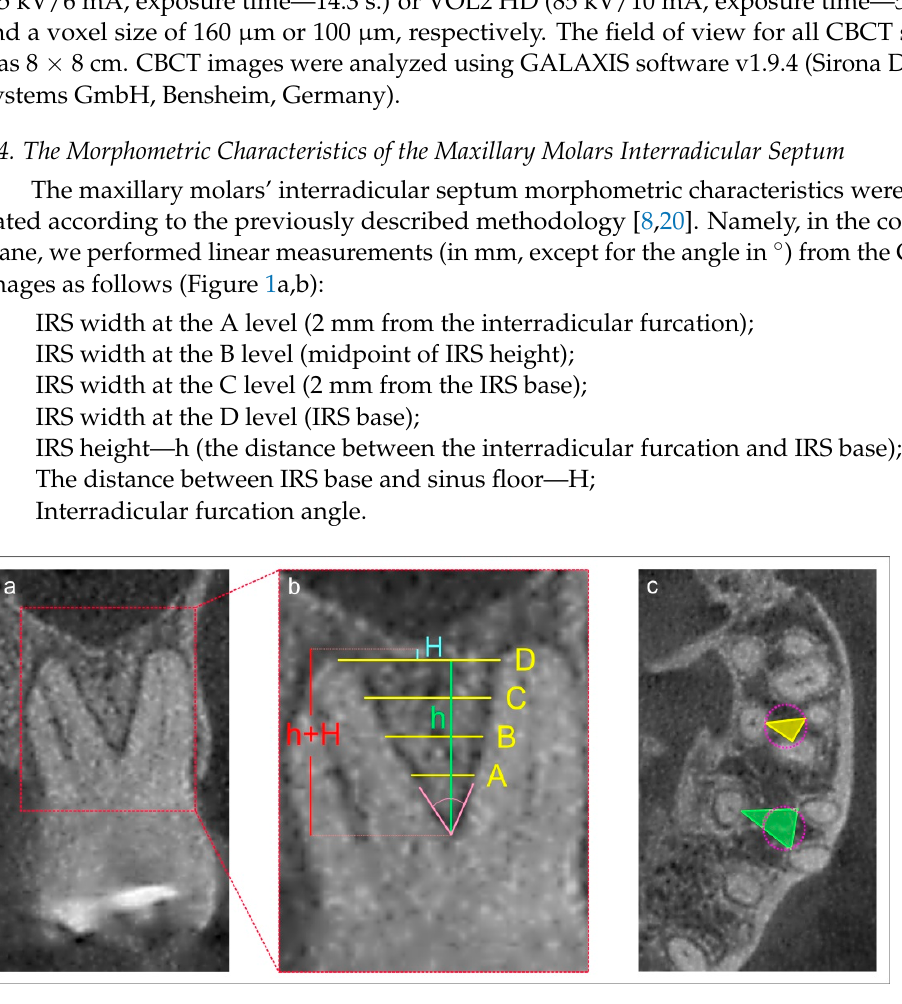
Figure 1. The morphometric evaluation of CBCT images of the maxillary molar region in the coronal view (CBCT image— a , with landmarks— b ), and in the axial view ( c ). The morphometric evaluation of CBCT images in the axial view, at the C level (the triangle represents the calculated IRS surface area—green for the first molars; yellow for the second; the commonly used implant diameter in the posterior maxilla is encircled).